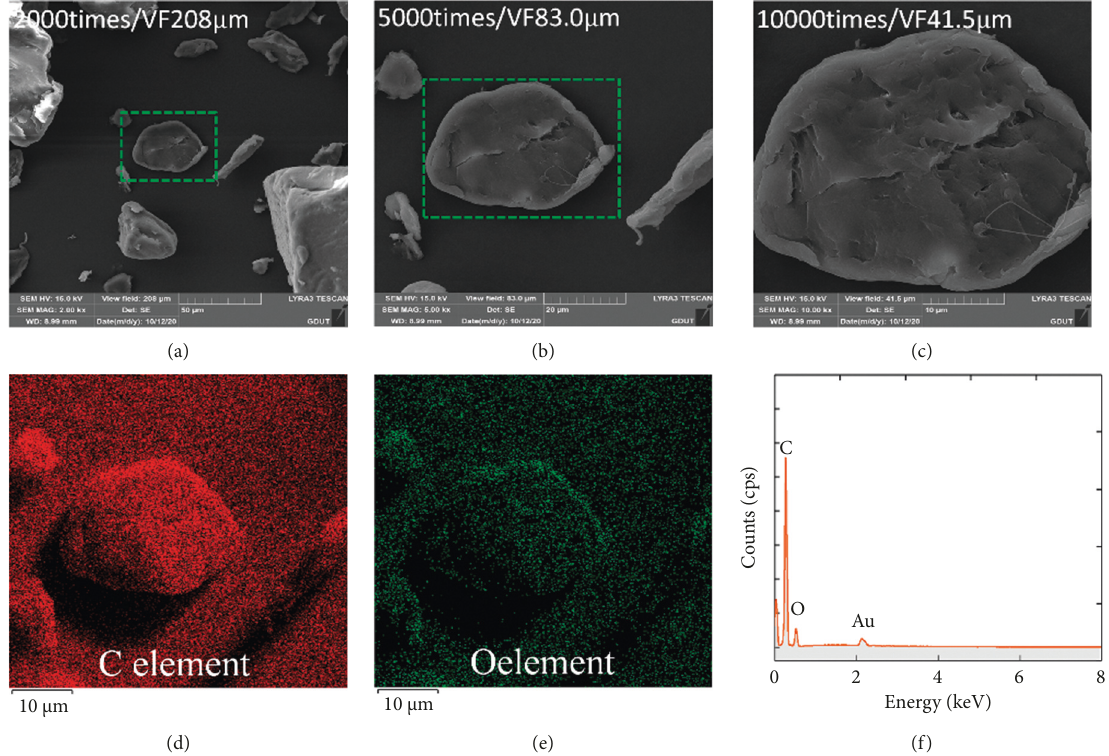
Figure 7: The microscopic morphology and elemental composition of T622 light stabilizer. (a) 2000 times. (b) 5000 times. (c) 10000 times. (d, e) Element mapping diagram. (f) EDS energy